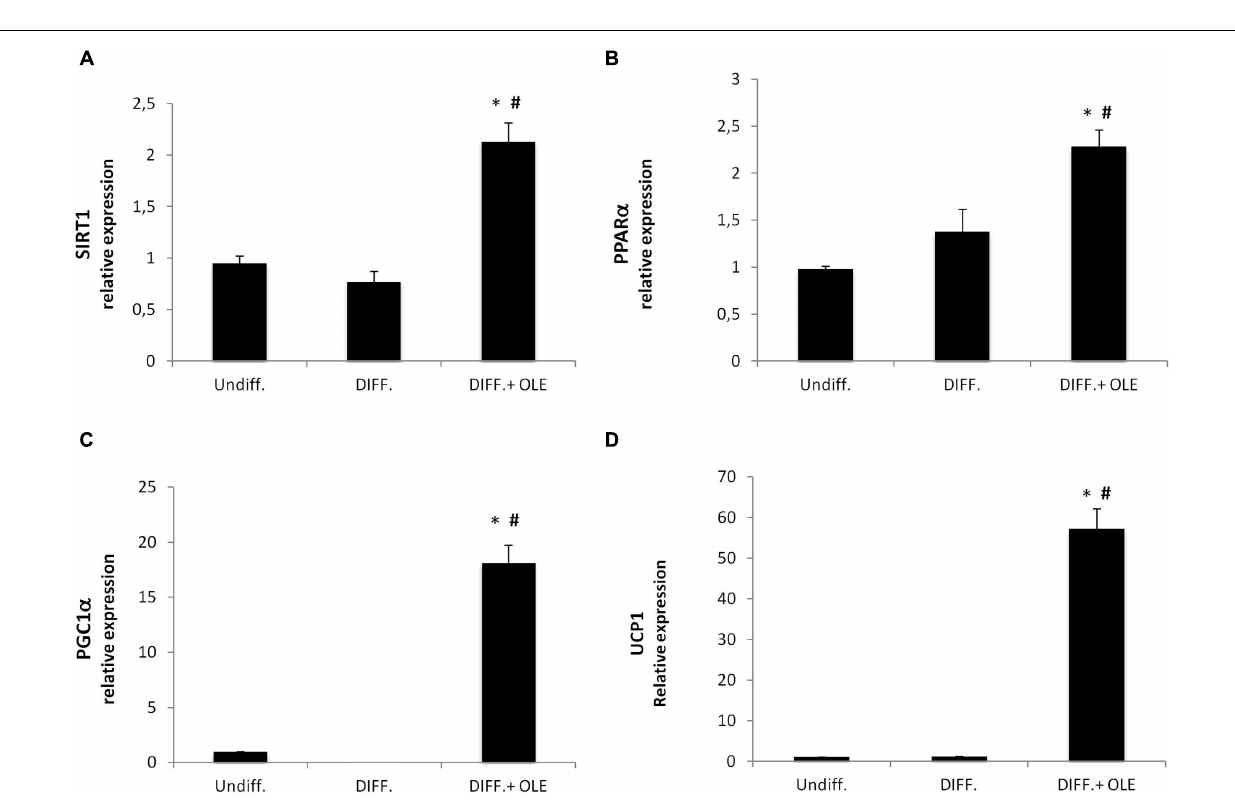
Frontiers in Pharmacology |